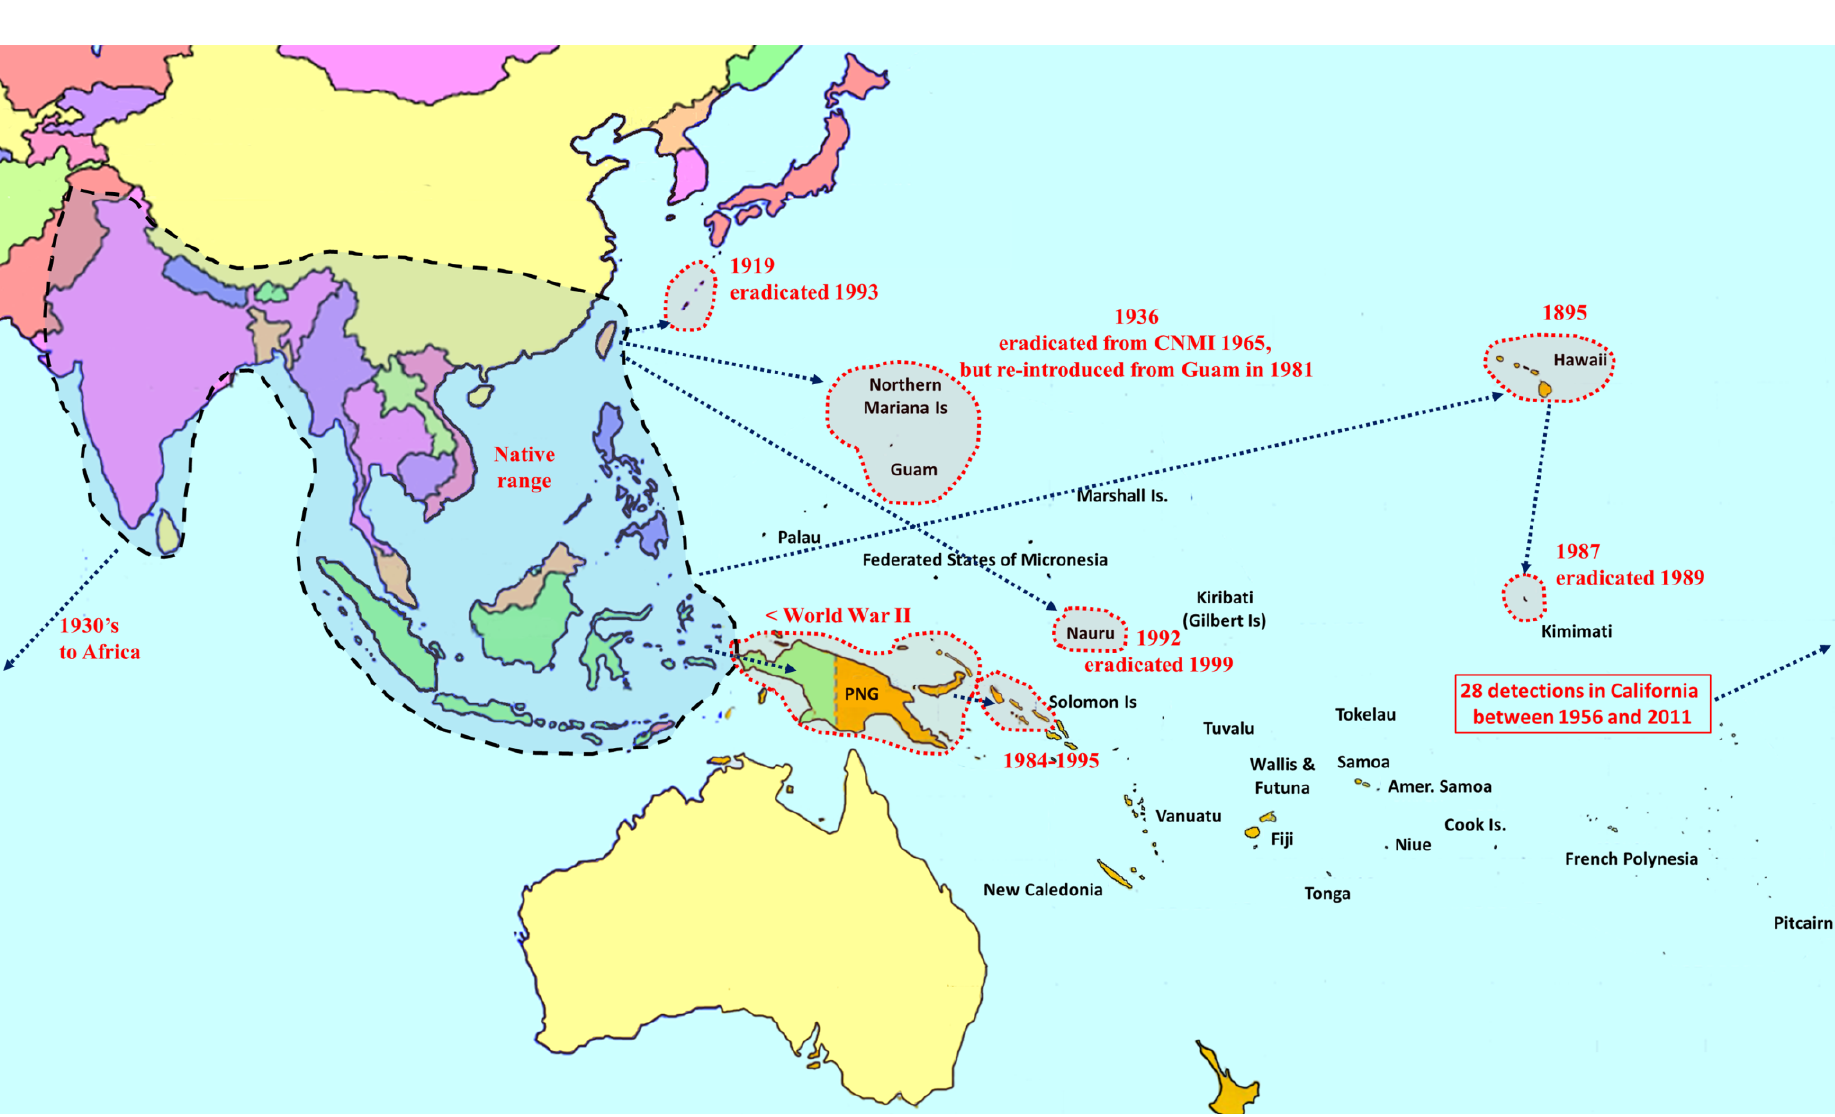
Figure 2. Distribution and invasion history of melon fly ( Bactrocera cucurbitae